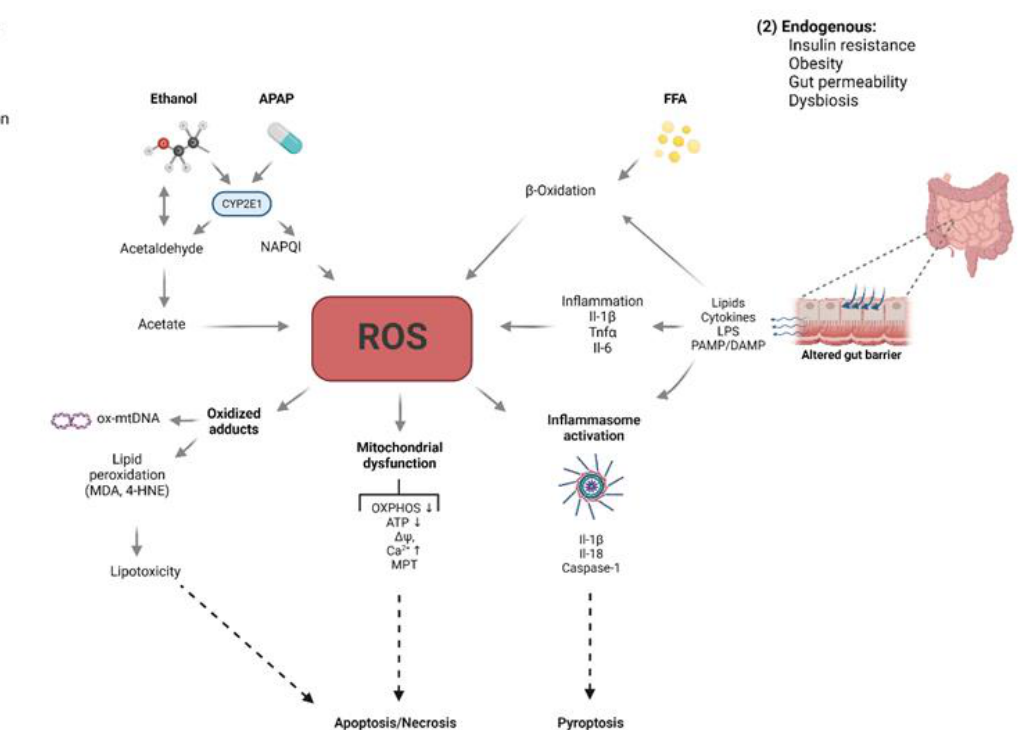
Figure 1. Reactive oxygen species can be produced by (1) exogenous sources such as alcohol, drugs, virus infection, UV light, radia- tion, stress, and smoking, or (2) endogenous sources during metabolic pathways in which oxygen is involved. The metabolism of molecules like ethanol, drugs (such as APAP), and FFA in hepatocytes induce an increment in ROS formation in the mitochondria that in turn provokes mitochondrial dysfunction. The accumulated ROS can react with cellular biomolecules (lipids, proteins, and DNA) and alter or impede their functioning. The generation of these oxidized adducts extends oxidative damage and favors cellular death. Moreover, ethanol consumption and lipid-enriched diets can lead to the loss of the intestinal barrier integrity permitting the entry of microbial products or saturated-FA to the circulation that release pathogen-associated molecular patterns (PAMPs)/damage- associated molecular patterns (DAMPs) and trigger the activation of cytokines (Il- 1β, Il - 6, Tnfα) leading to inflammation. APAP: acetaminophen; ATP: adenosine triphosphate; Ca 2+ : calcium ion; CYP2E1: cytochrome P450 2E1 oxydase; FFA: free fatty acids; HNE- 4: 4-Hydroxynonenal; LPS: lipopolysaccharide; MDA: malonaldehyde; MPT: mitochondrial permeability transition; NQO1: NAD(P)H: Quinone Oxidoreductase 1; OXPHOS: oxidative phosphorylation system; PAMPs: pathogen-associated molecular pat- terns; ROS: reactive oxygen species; UV: ultra violet; ∆Ψ: mitochondrial membrane